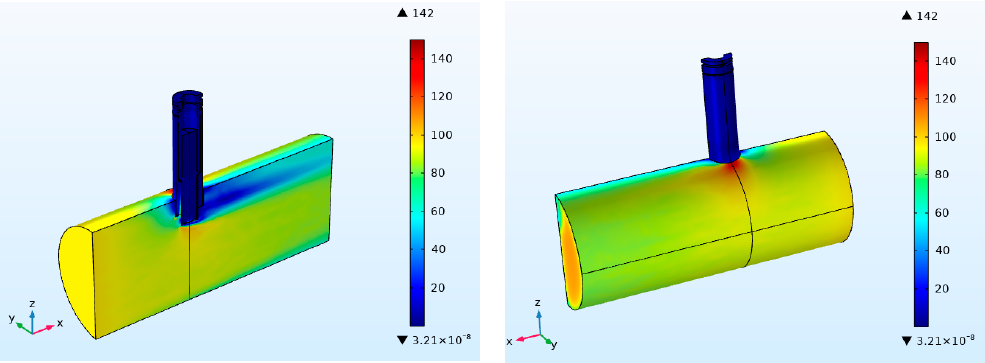
Figure 3. Speed distribution in sensor and exhaust pipe.